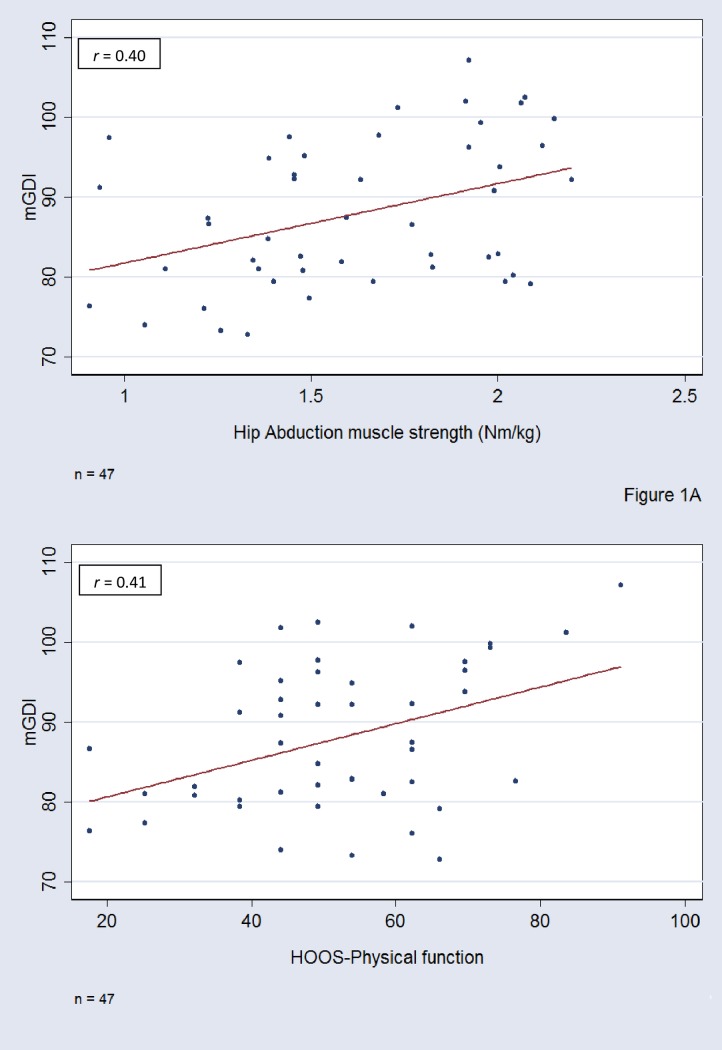
A-B. Representative examples of the association between mGDI and clinical outcomes.